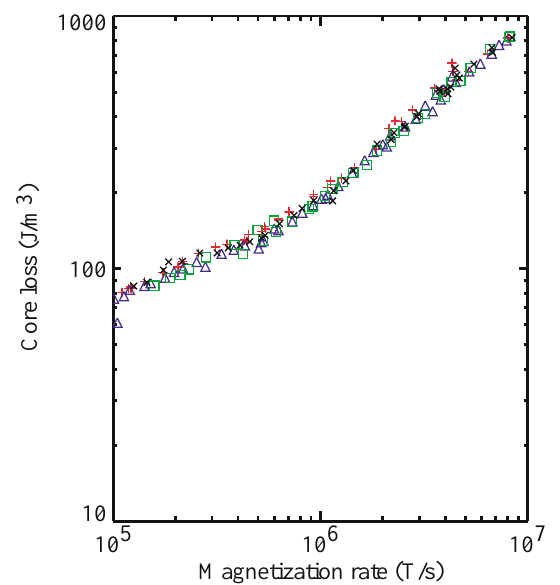
FIG. 21. (Color) Core loss versus magnetization rate for three varieties of nanocrystalline cores, manufactured by Hitachi and NAM, one core shown twice. The data are for the listed flux swings: ( (cid:1) , green, heavy line) FT-2H 99Z-4 at 2.40 T; ( 3 , black, solid line) FT-2H 99Z-4 at 2.10 T; ( (cid:3) , blue, dashed line) FT-1H 982-1 at 2.10 T; and ( 1 , red, solid line) NAM-nano-3 at 2.10